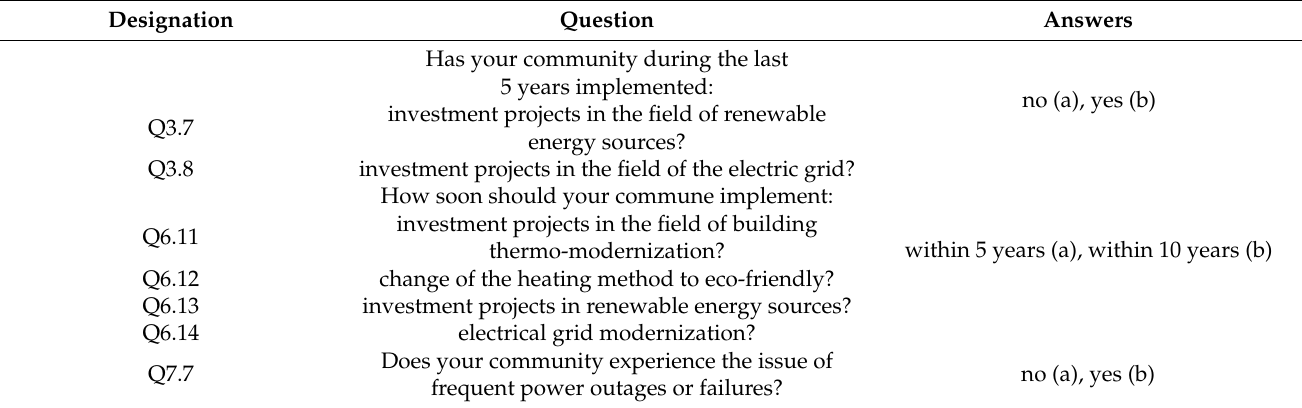
Table A1. Questions used for the classification model together with possible